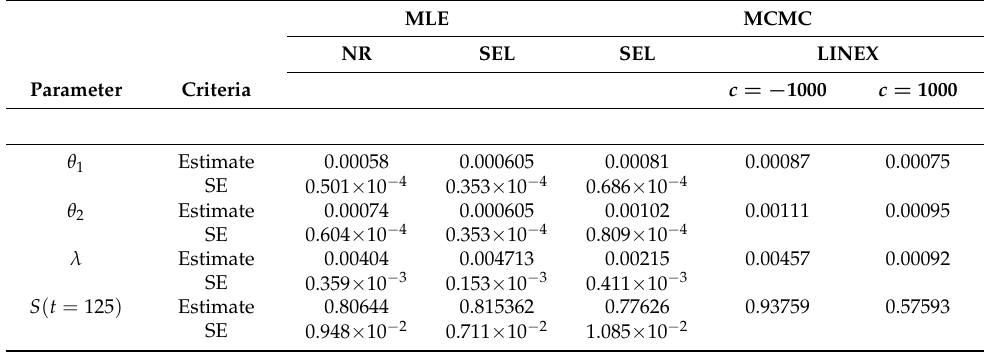
Table 6. ML and Bayes estimates of θ 1 , θ 2 , λ , and S(t) for Xia et al. (2009) data.